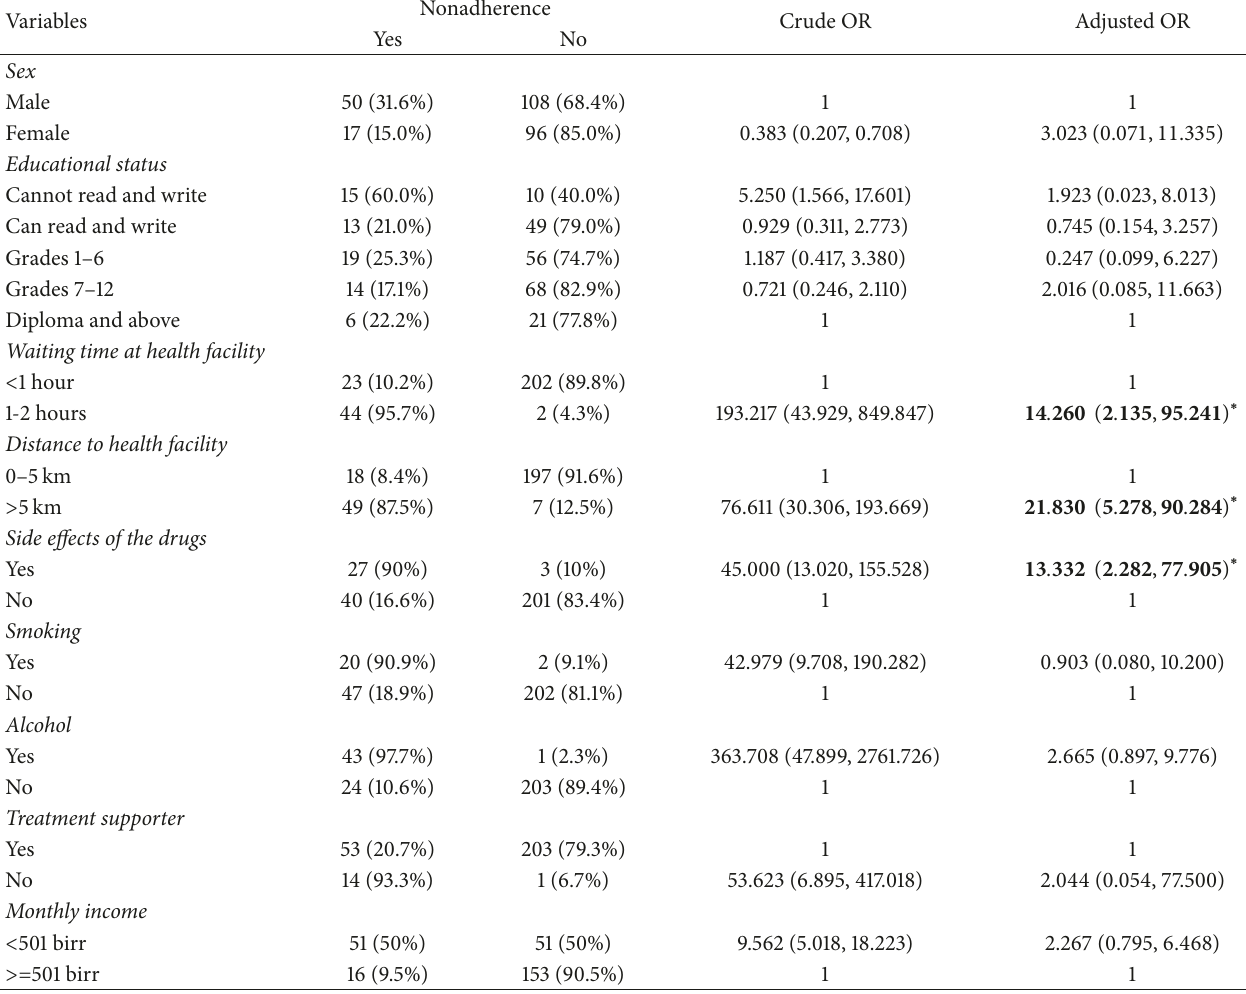
Table 5: Factors associated with nonadherence of anti-TB drug treatment among TB patients that attended TB clinics at governmental health institutions of Arba Minch town, Southern Ethiopia (𝑁 = 271)